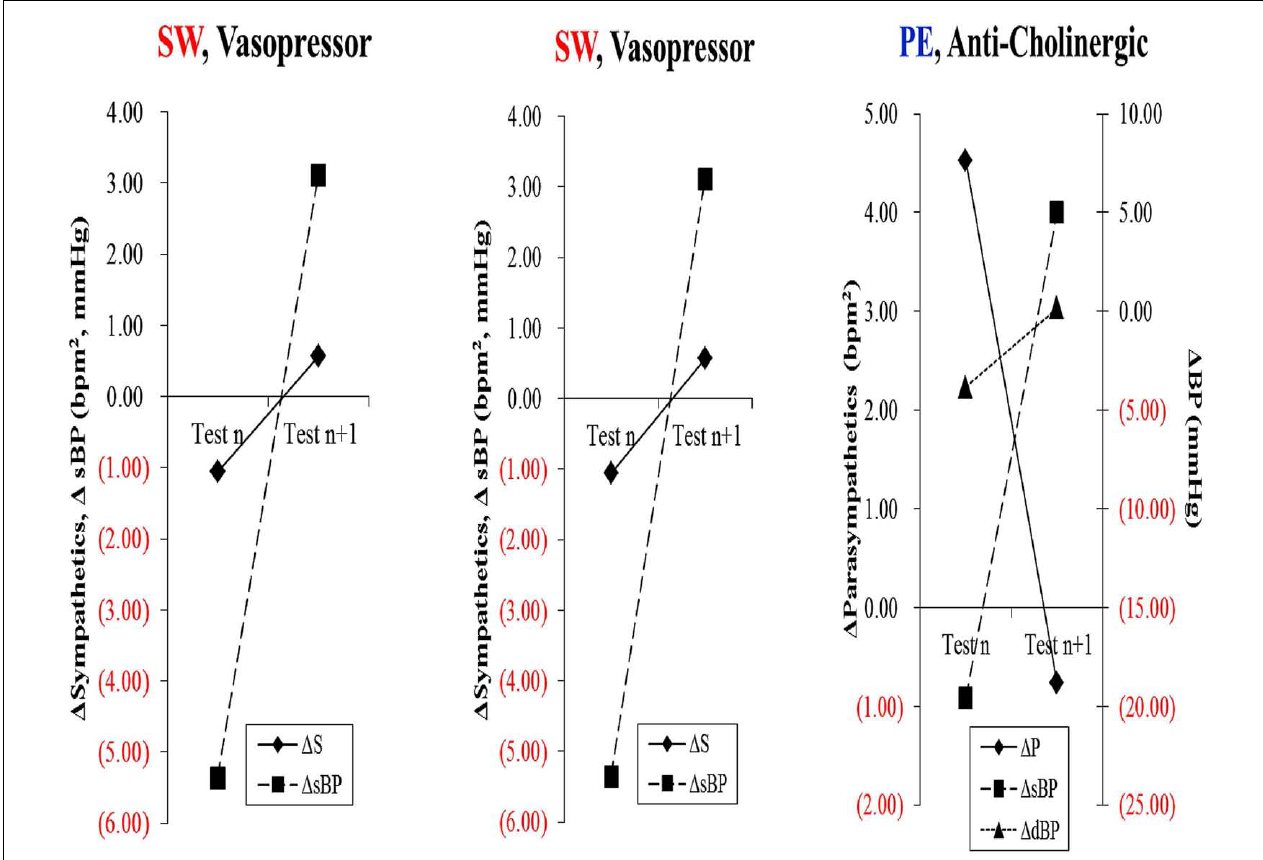
FIGURE 7 | Restoration of autonomic